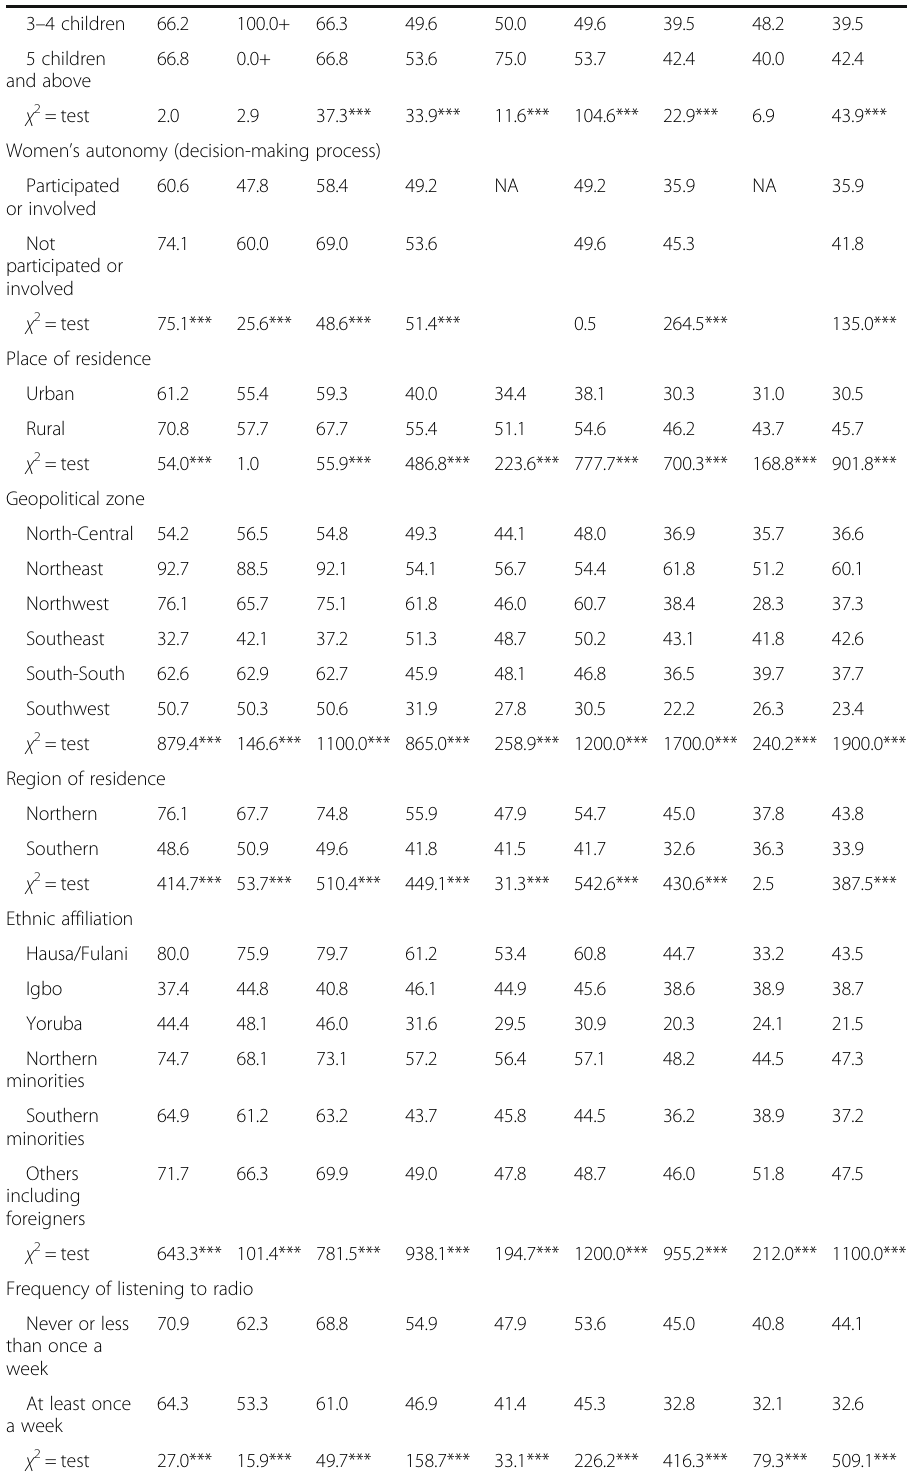
Table 2 Percent distribution of women who agreed that a husband is justified for beating his wife by marital status according to individual characteristics, 2003, 2008, and 2013 Nigeria Demographic and Health Survey